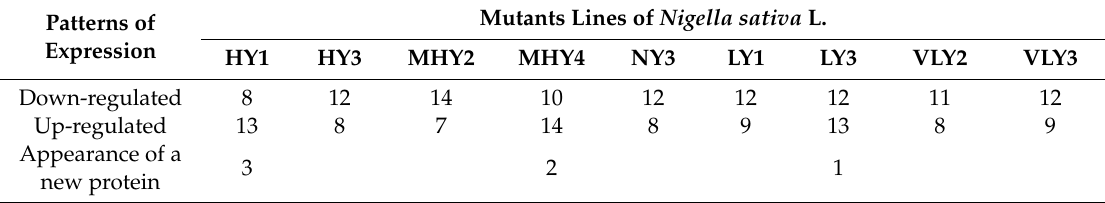
Table 3. Number of di ff erentially expressed proteins in the leaves of the mutant lines of Nigella sativa L. The expression patterns of the proteins were compared with those of the control plant. Patterns of Mutants Lines of Nigella sativa